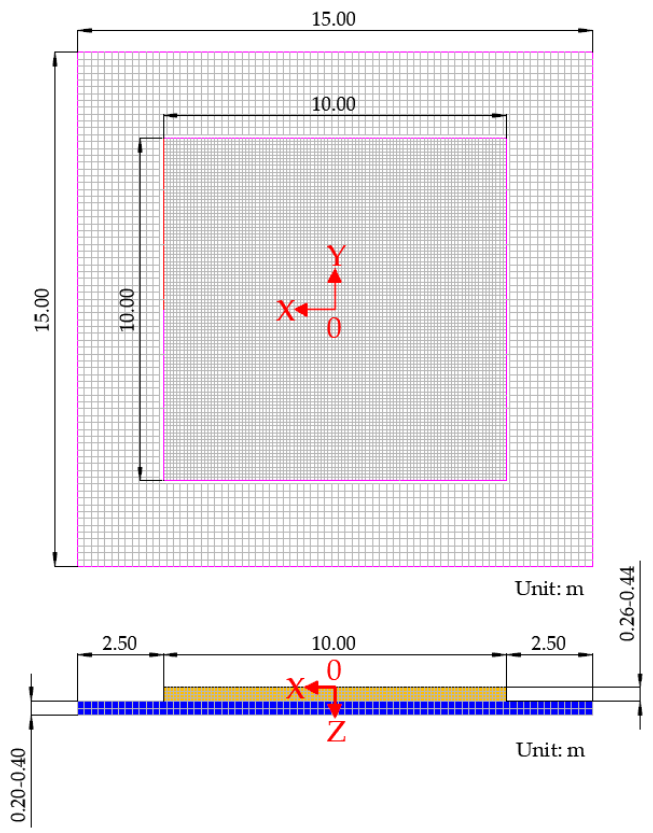
Figure 7. The three-dimensional finite element models developed in this paper. Table 4. Variation parameters of analyzed cases in this paper. Table 3. The parameters of pavement structure and material properties used in the